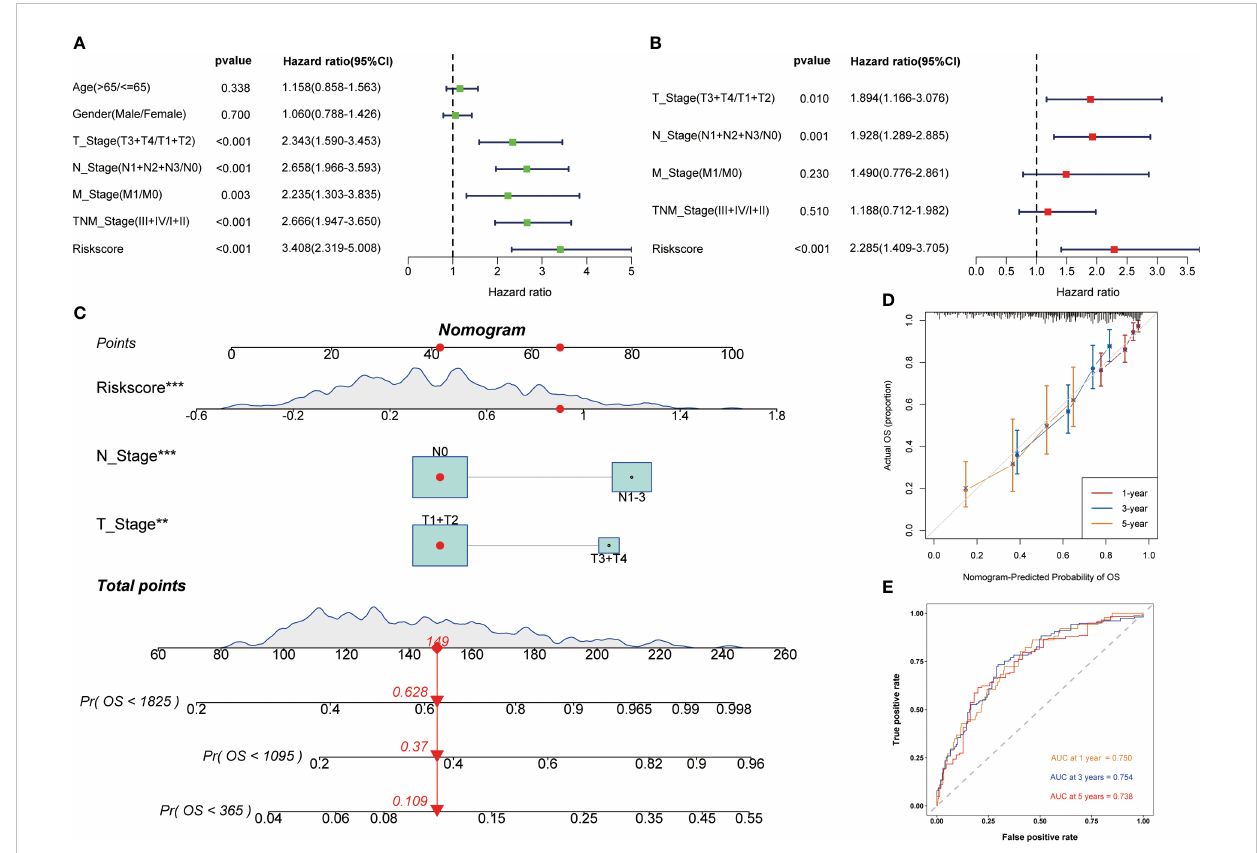
FIGURE 4 Development of the nomogram to predict the prognosis. Univariate (A) and multivariate (B) Cox regression analysis. (C) Nomogram for the prediction of 1-, 3- and 5-year survival probability. (D) Calibration curves for evaluating the accuracy. (E) ROC curves of the nomogram. **p < 0.01, ***p <